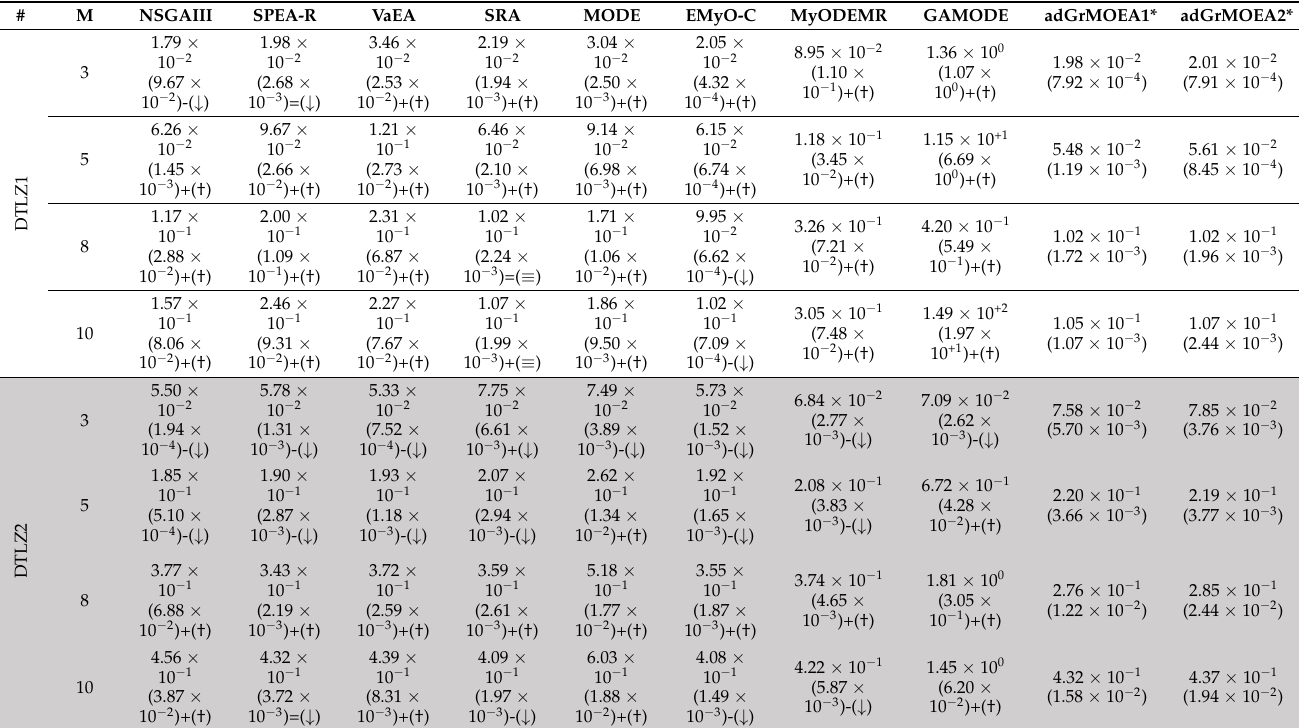
Table A5. Mean and standard deviation values of IGD results of proposed method with state of art algorithms on DTLZ